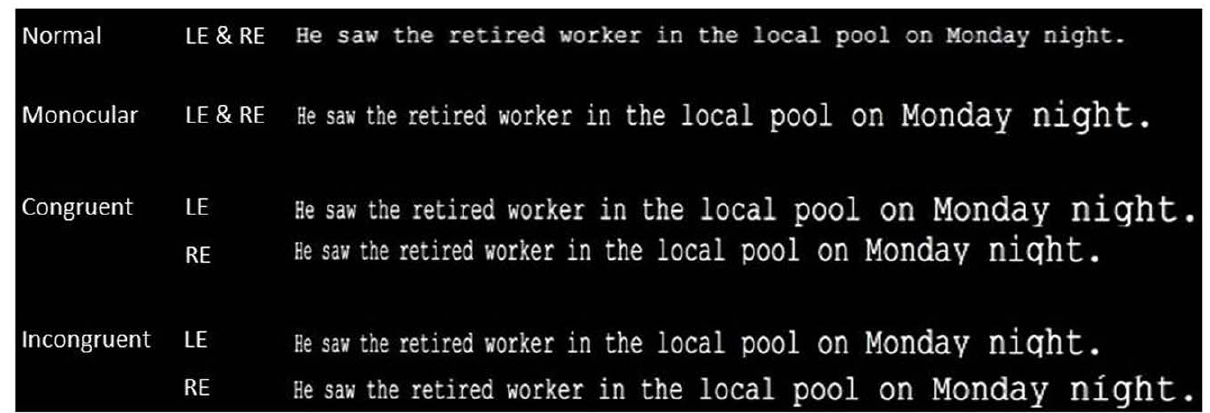
Figure 1. Examples of stimuli in the four experimental conditions: monocular cue, normal, congruent (retinal size and disparity cues for a looming sentence), and incongruent (retinal size cues for a looming sentence, disparity cues for a receding sentence).